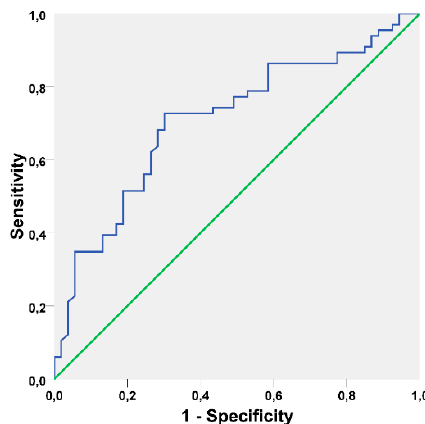
disease with the bone level located on the implant’s 9th thread.